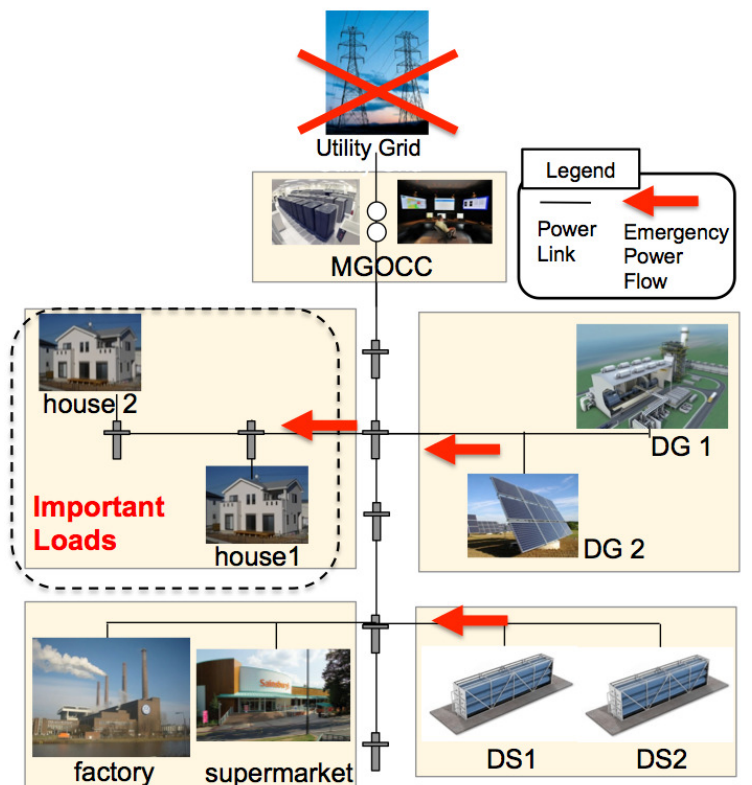
Figure 7. Overview of the simulated